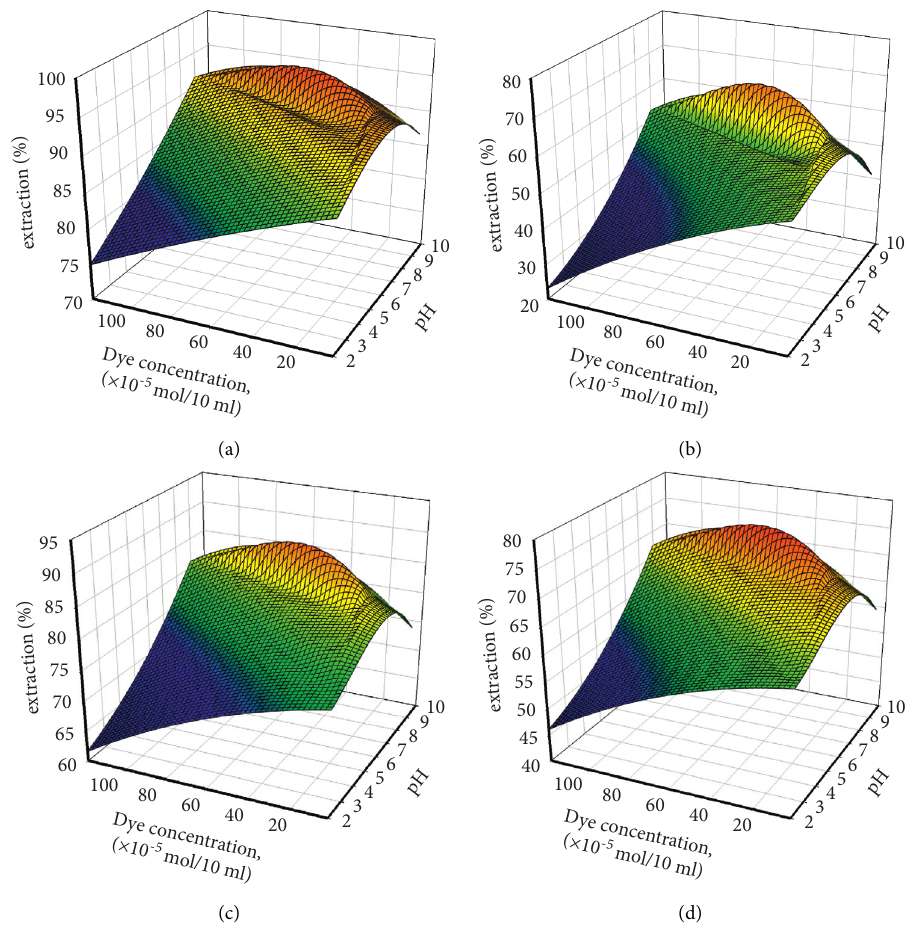
Figure 5: 3D plots of the interaction influence of solution pH and the initial concentration of RY145 dye on extraction% by (a) CTAB and (b) SDS and RB222 dye by (c) CTAB and (d)